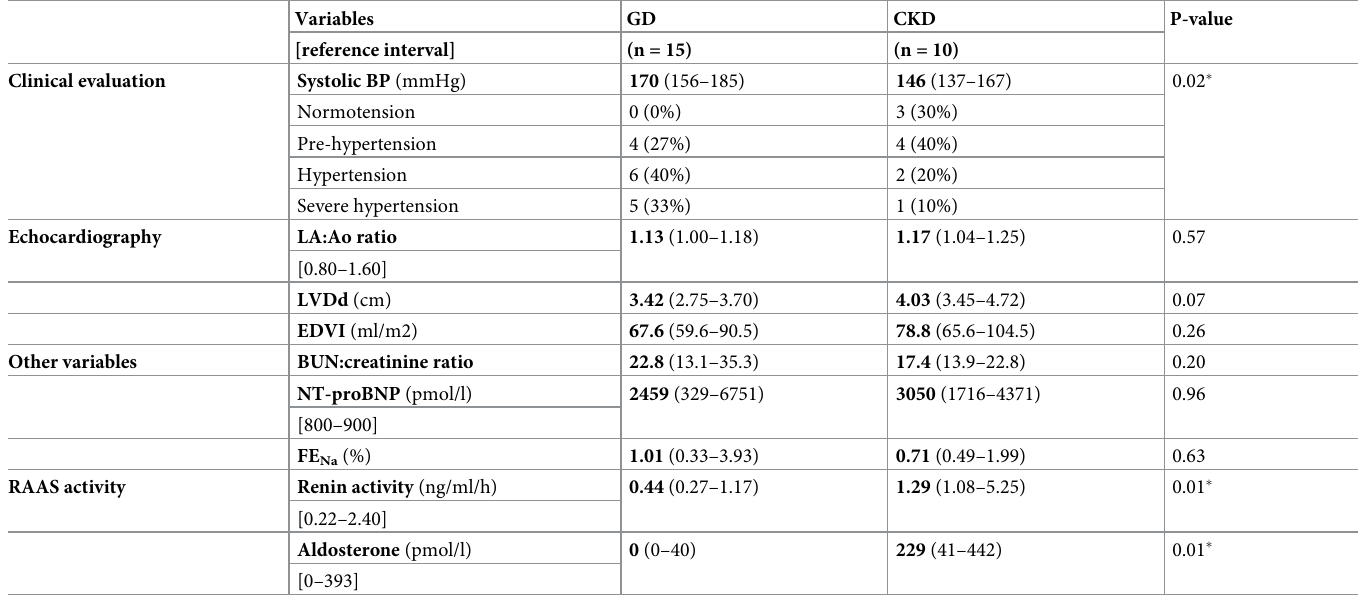
Table 3. Clinical, echocardiographic, laboratory, and neuroendocrine variables putatively associated with the fluid status in dogs with glomerular disease (GD) or chronic kidney disease